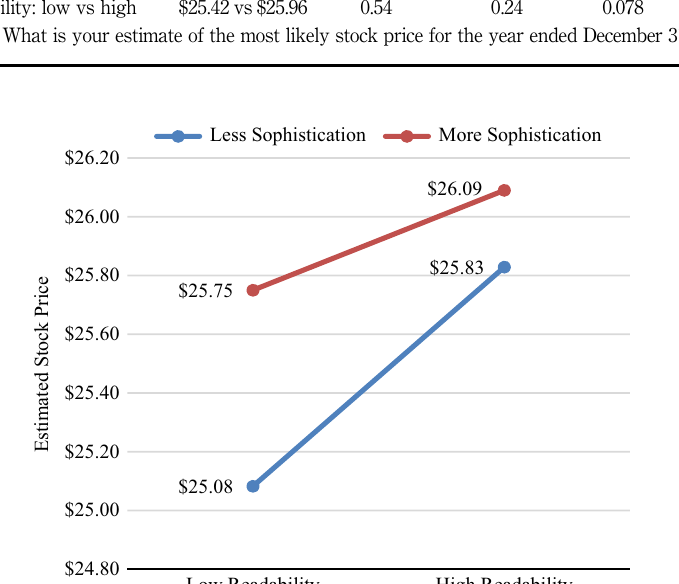
Figure 1. Equity valuation by readability and sophistication